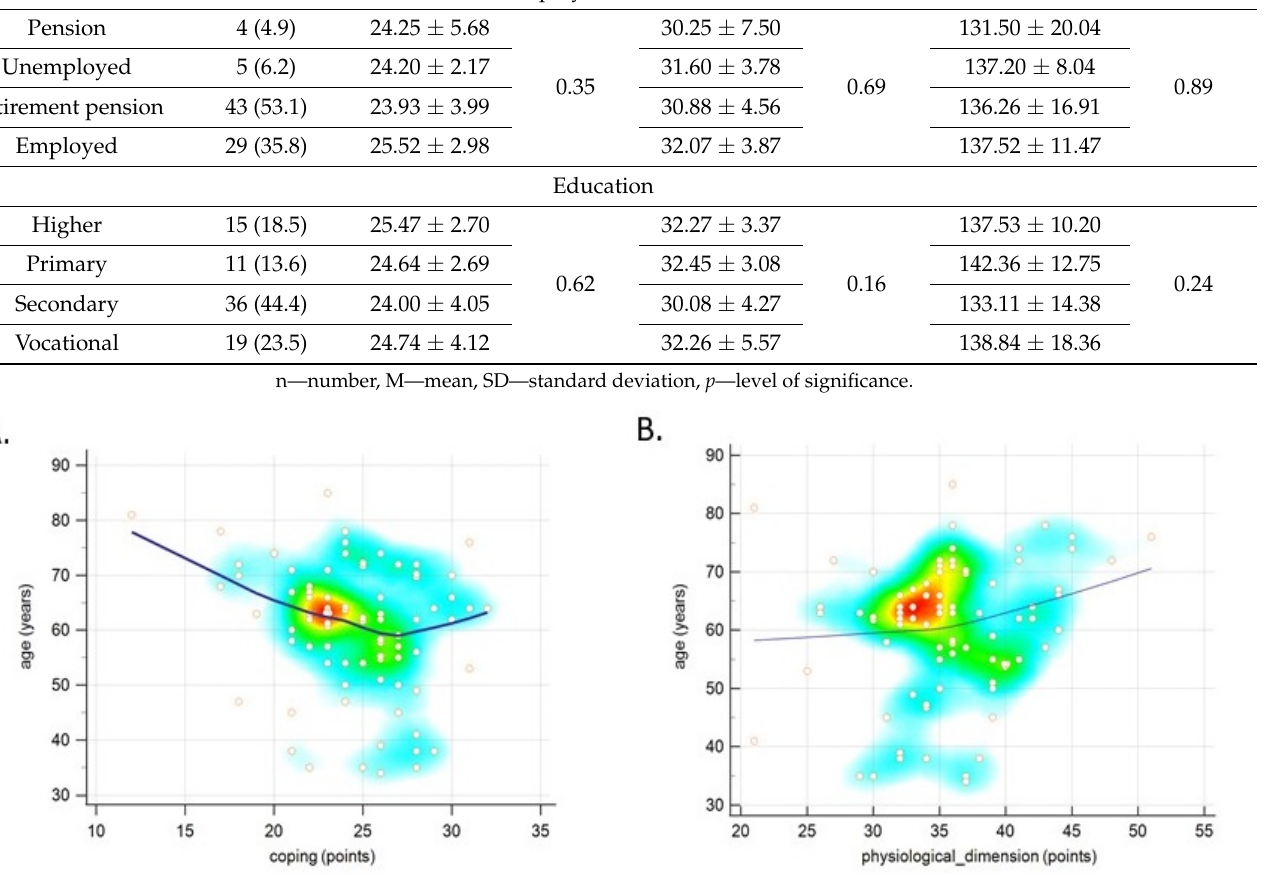
Figure 4. Correlation of age with CAPS subscales: coping ( A ) and physiological dimension ( B ) in all study participants.